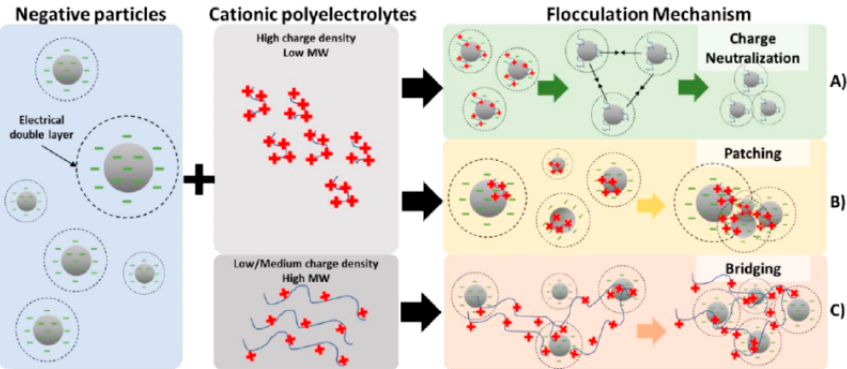
Figure 10. Illustration of the hypothetic flocculation mechanisms occurring among negatively charged particles and cationic polyeletrolytes: ( A ) charge neutralization, ( B ) patching and ( C )